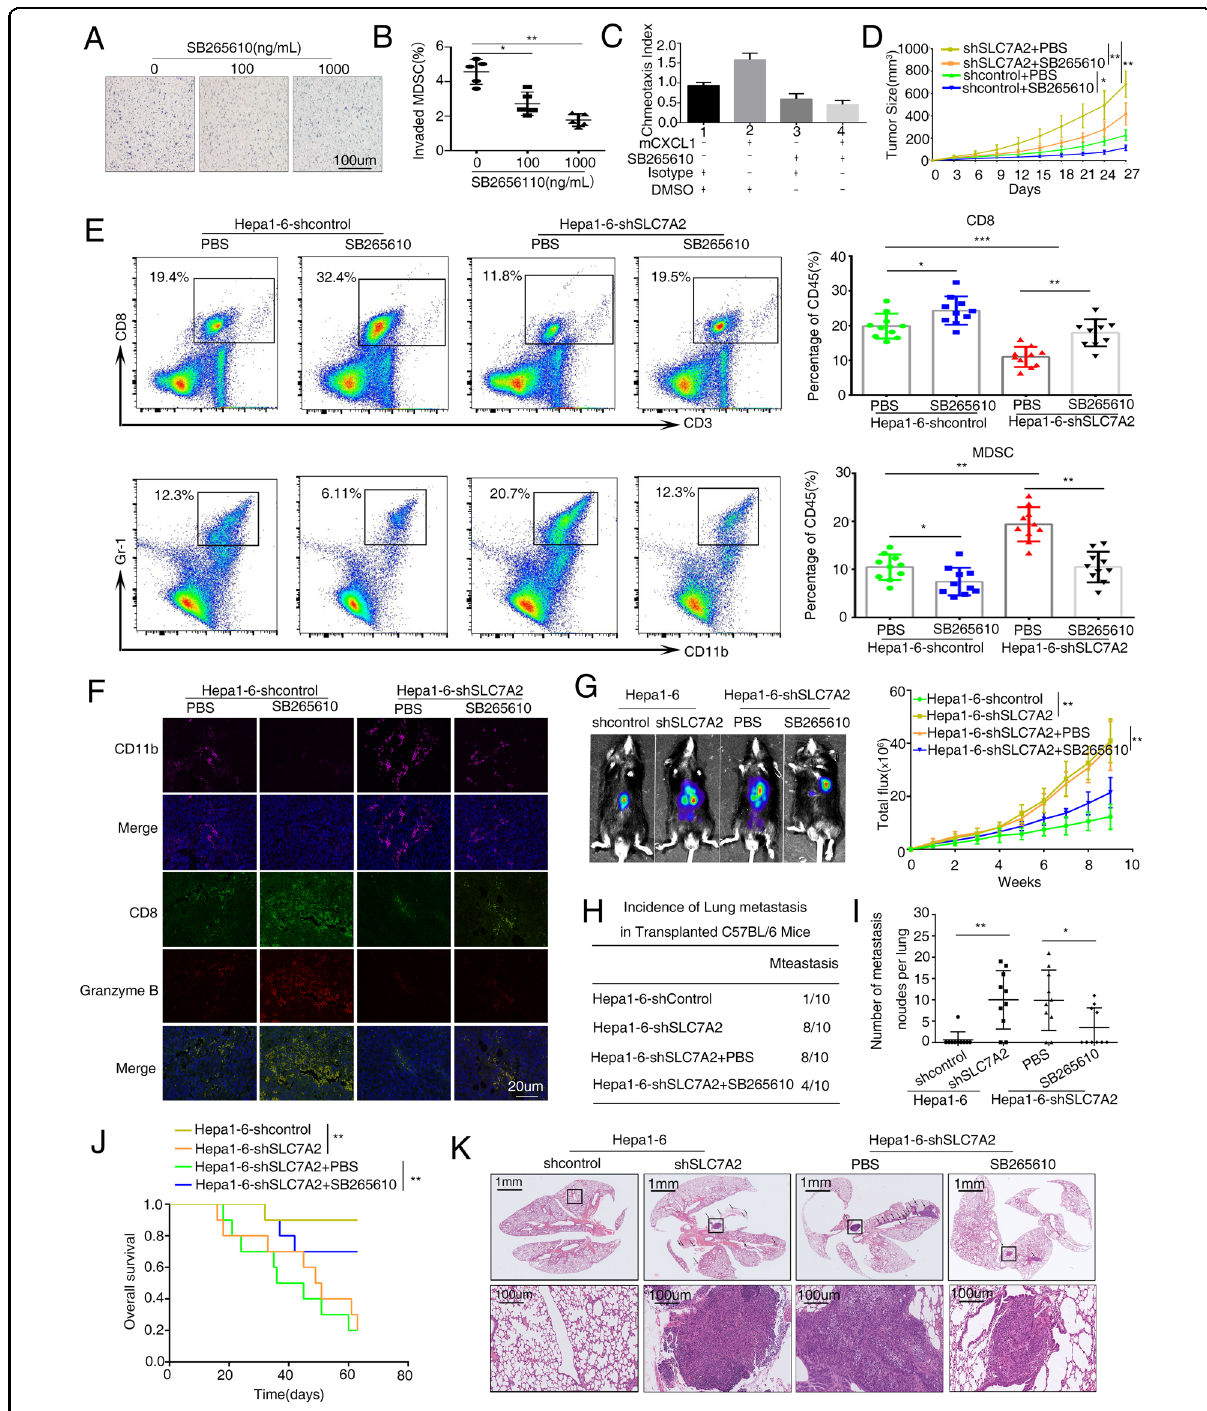
Fig. 6 (See legend on next